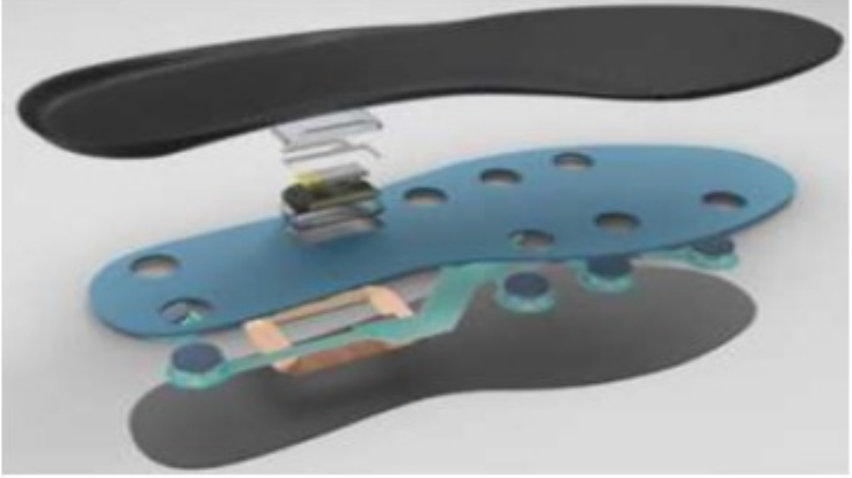
Figure 1. Sensor structure of smart insole